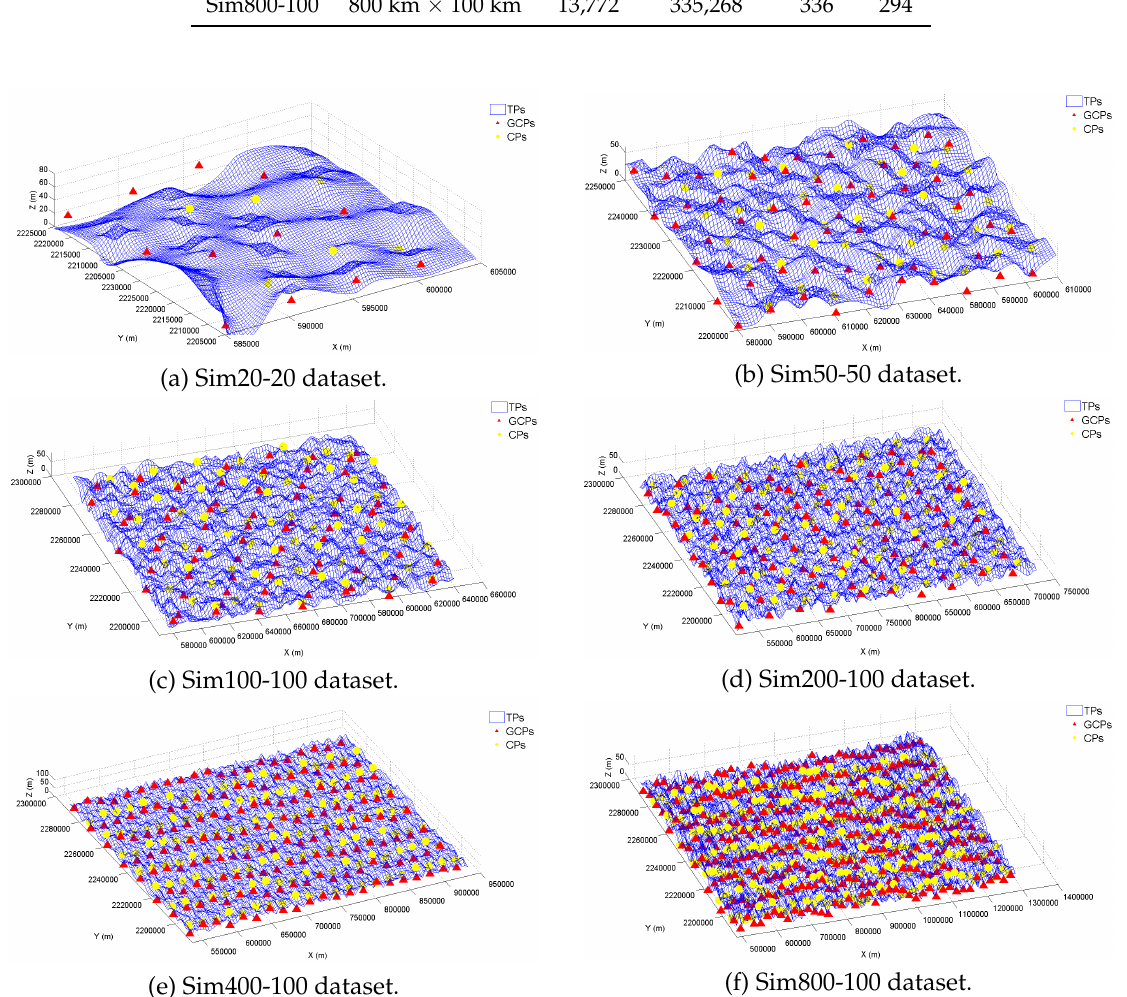
Figure 5. The spatial distribution of GCPs, CPs and 3D tie points of six synthetic datasets. The red triangles and yellow circles represent GCPs and CPs, respectively. Additionally, TPs are drawn with blue quadrangles. ( a ), ( b ), ( c ), ( d ), ( e ) and ( f ) represent the spatial distribution of Sim20-20,